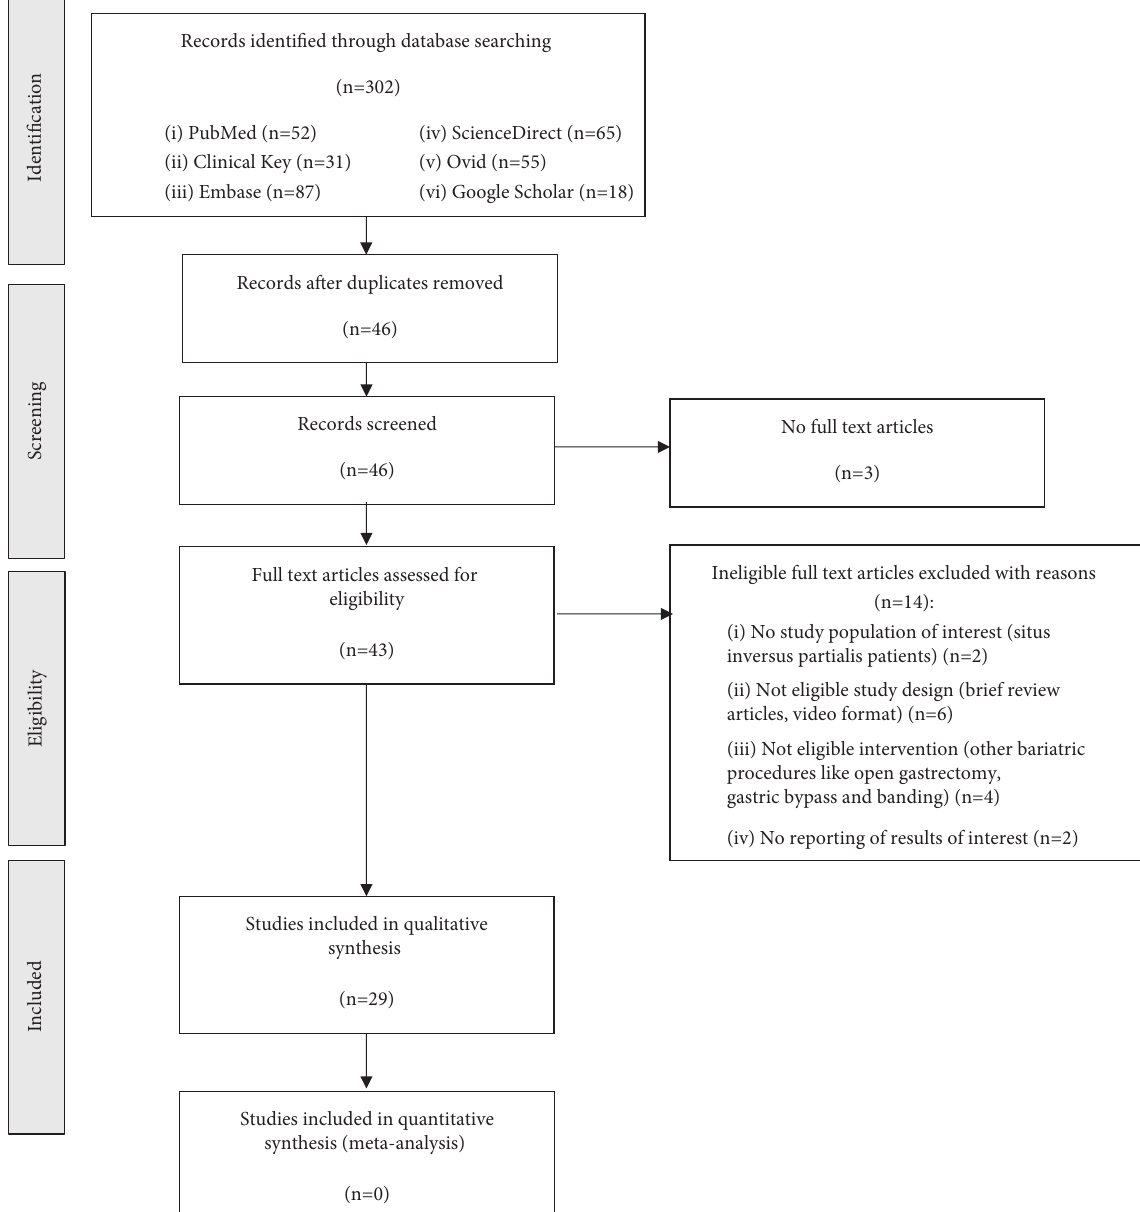
Figure 1: Flowchart showing search strategy and selection of retained articles for